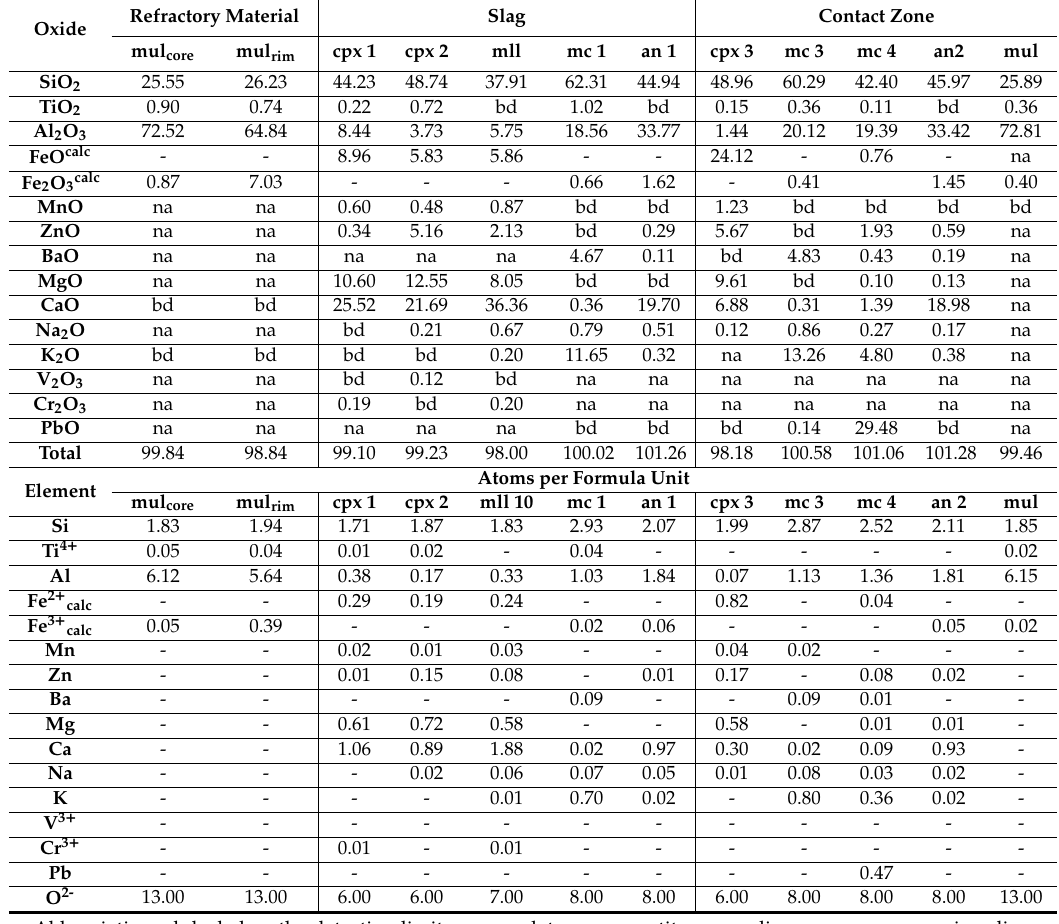
Table 4. Representative EPMA data for silicates occurring in the analysed